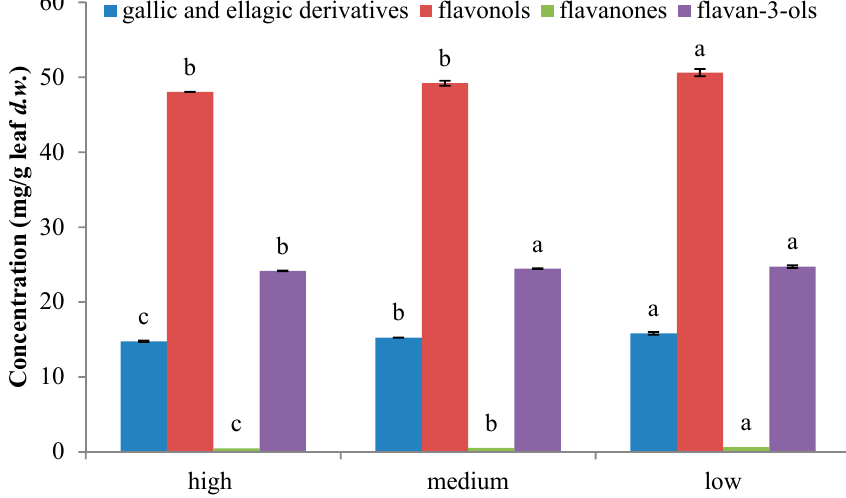
Figure 2. Quantification of different families of phenolic compounds present in guava leaves at different oxidative states. The different letter (a,b,c) in the same phenolic class means a significant difference ( p ≤ 0.05).